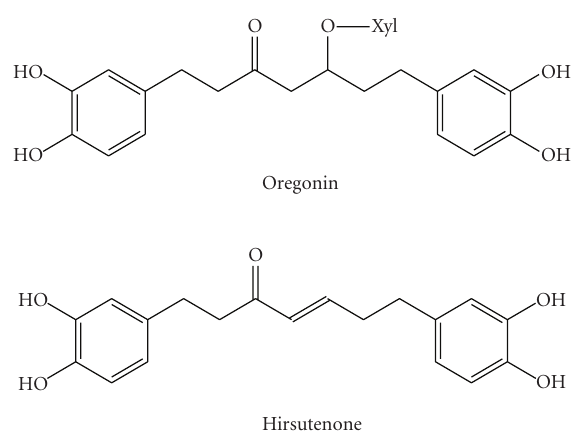
Figure 1: Chemical structures of oregonin and